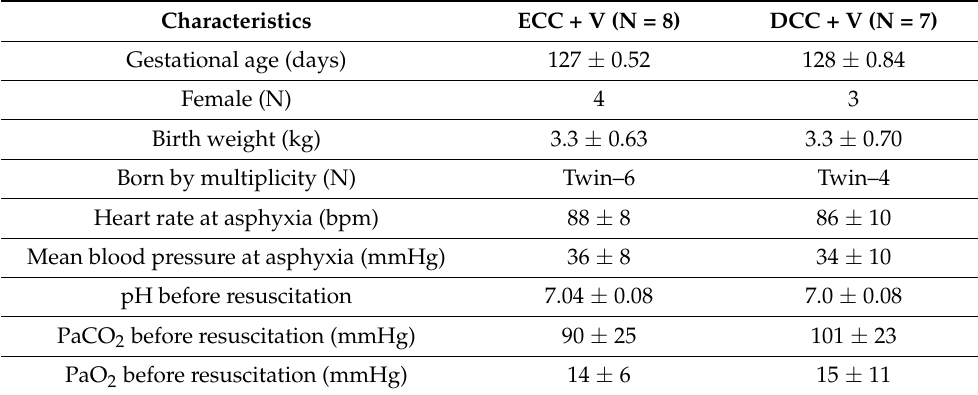
Table 1. Characteristics of preterm